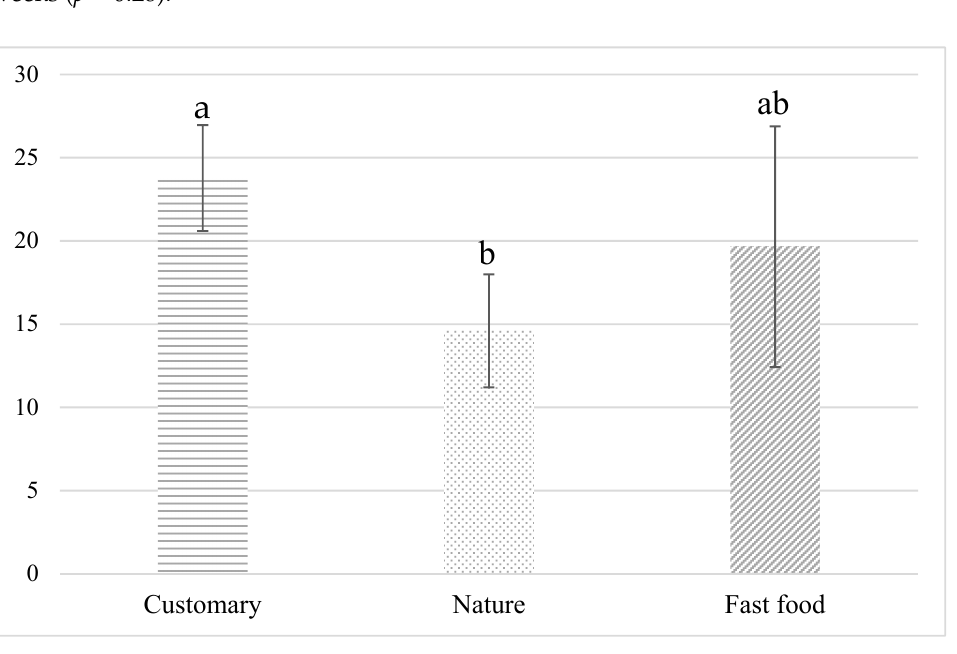
Figure 7. Average plate waste in grams per customer during the ‘customary ambience’, ‘nature ambience’ and ‘fast food ambience’ weeks. Data from each day of the study weeks ( n = 15). Error bars are standard deviations of the five days of the study week. Different letters above the bars indicate statistically significant difference ( p ≤ 0.1) between the study weeks.